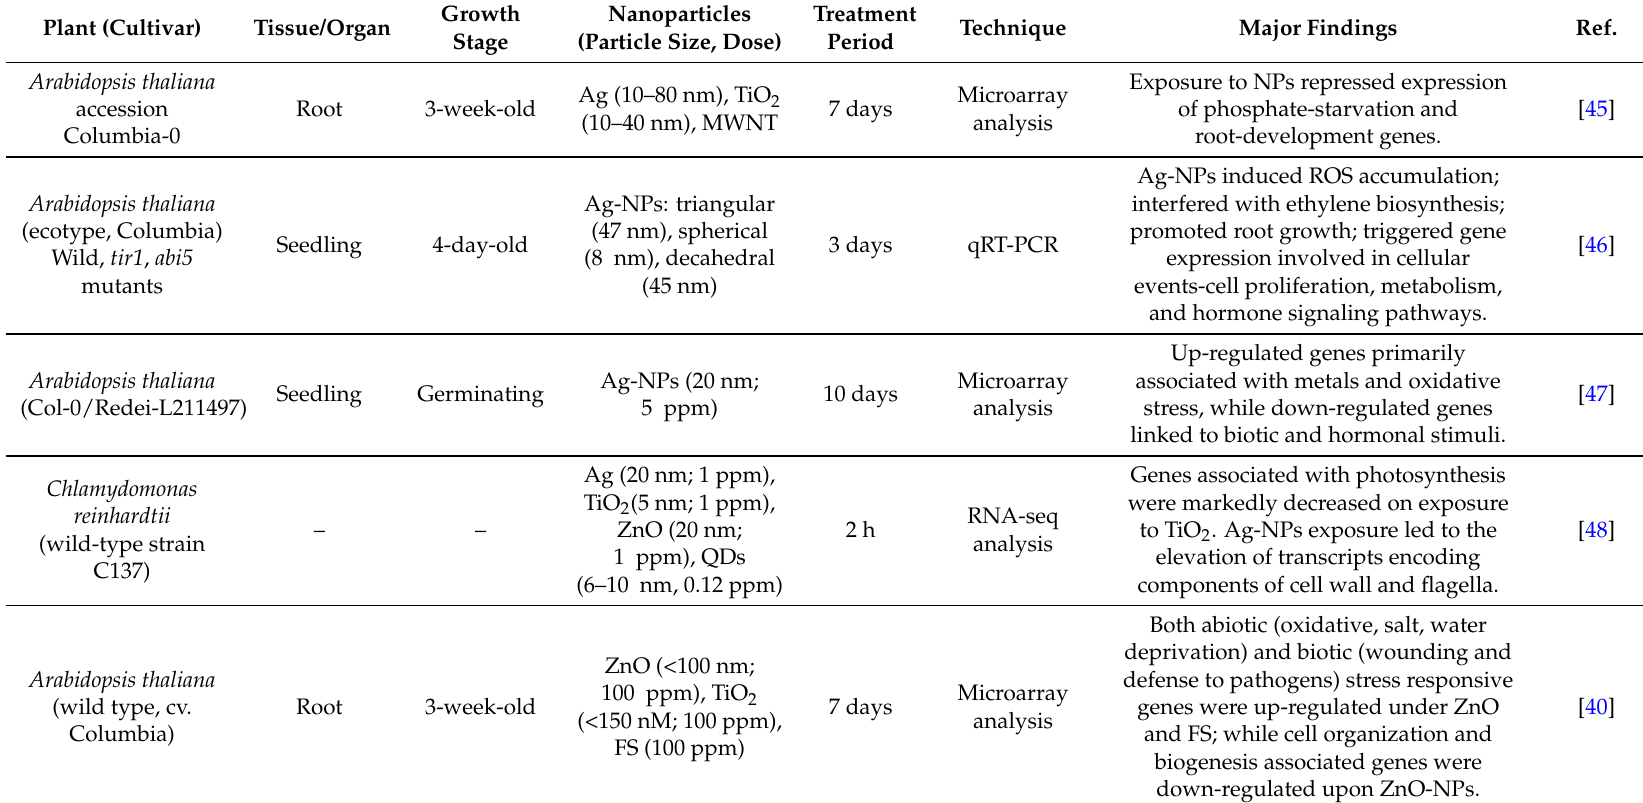
Table 1. Summary of gene expression analyses in response to nanoparticle